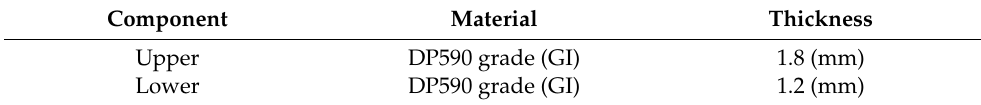
Table 1. Spec of components for vehicle parts.